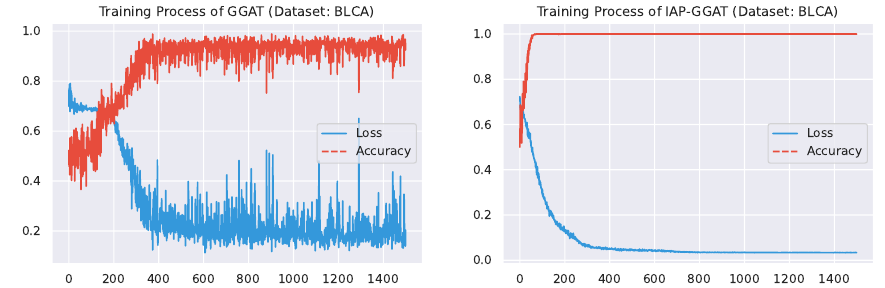
Figure 6. Training process of GGAT and IAP-GGAT on BLCA dataset.